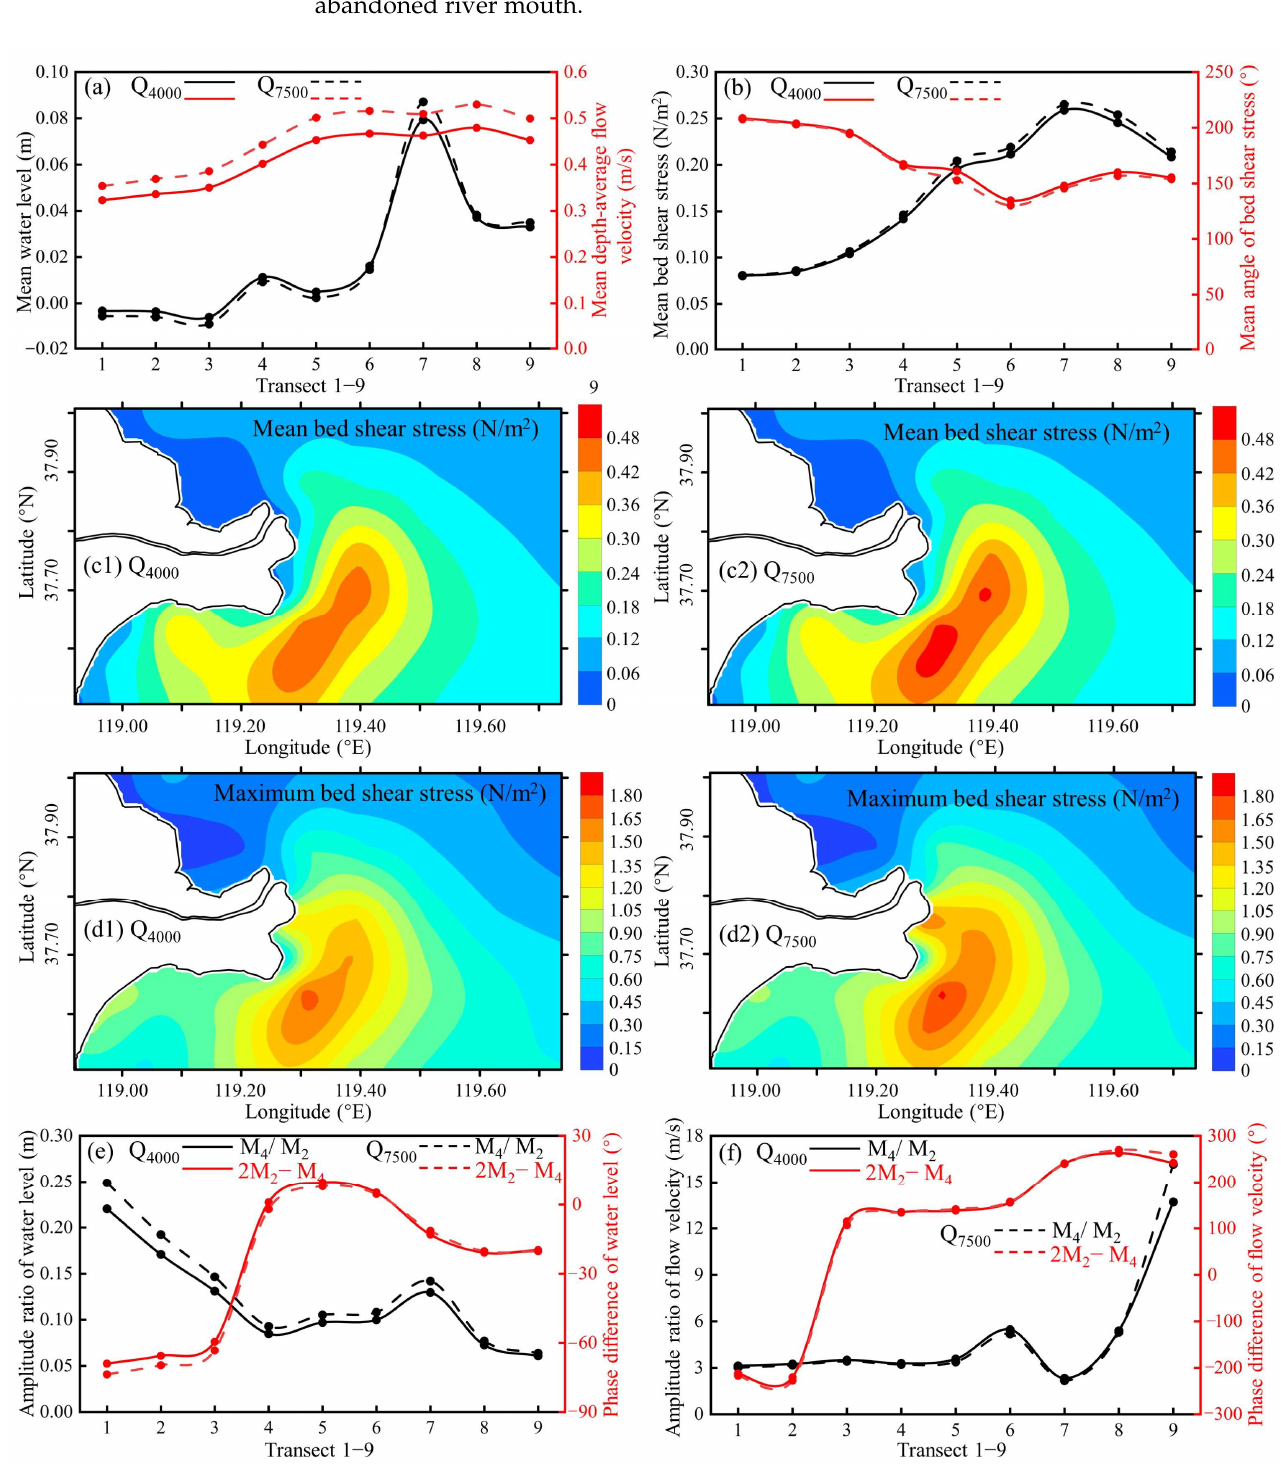
Figure 8. Q 4000 and Q 7500 runoff scenarios: modeled hydrodynamic results averaged over the 9 cross- sections in ( a ) mean water level and mean depth-averaged flow velocity, ( b ) mean bed shear stress and its angle. ( c , d ) Modeled mean and maximum bed shear stress in the YRD. ( e , f ) The amplitude ratio and phase difference of two constituents lead to tidal asymmetry.